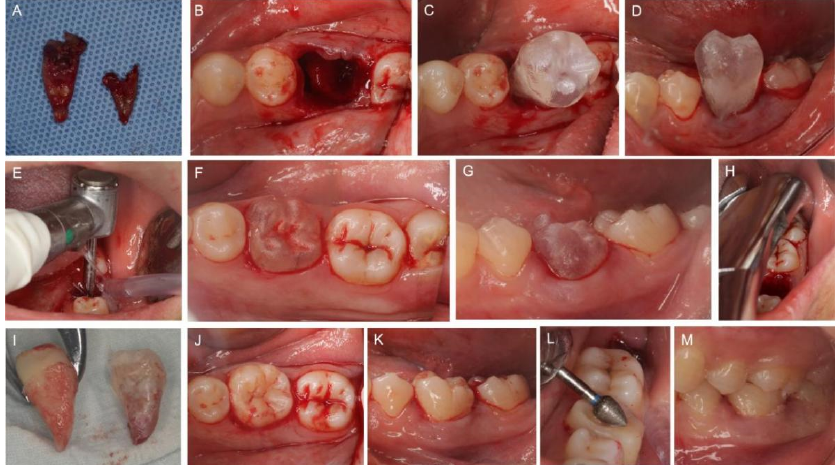
Figure 3. Autotransplantation of tooth #38 into the extraction socket of tooth #36. ( A ) Extracted tooth #36. ( B ) Double root of recipient site. ( C , D ) The replica donor tooth #38 is inserted into the extraction socket but does not fit well into the socket in the occlusal view ( C ) and buccal view ( D ). ( E ) Preparation of the recipient site with long neck round bur. ( F , G ) The replica tooth fits equitably well into the recipient site in the occlusal view ( F ) and buccal view ( G ). ( H ) Tooth #38 is extracted with minimal trauma. ( I ) Tooth #38 as compared with the replica tooth. ( J , K ) The donor tooth #38 is placed into the prepared bone socket immediately and fit well in the occlusal view ( J ) and buccal view ( K ). ( L ) Occlusal adjustment is performed. ( M ) Occlusion is checked at the end of